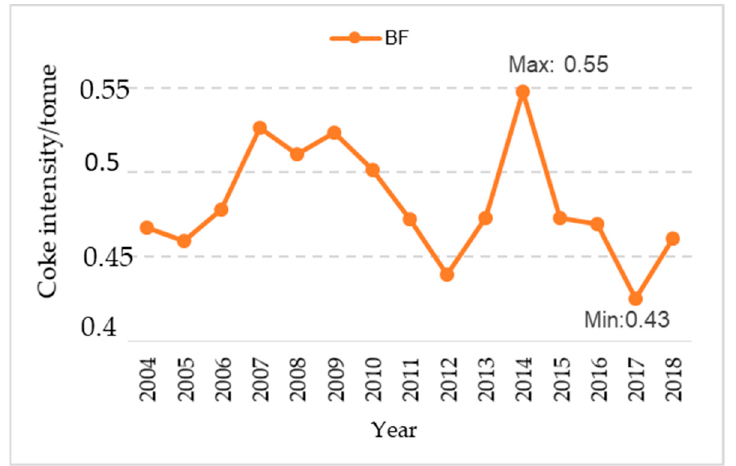
Figure 5. Unit consumption of coke by BF technology in Poland from 2004 to 2018.